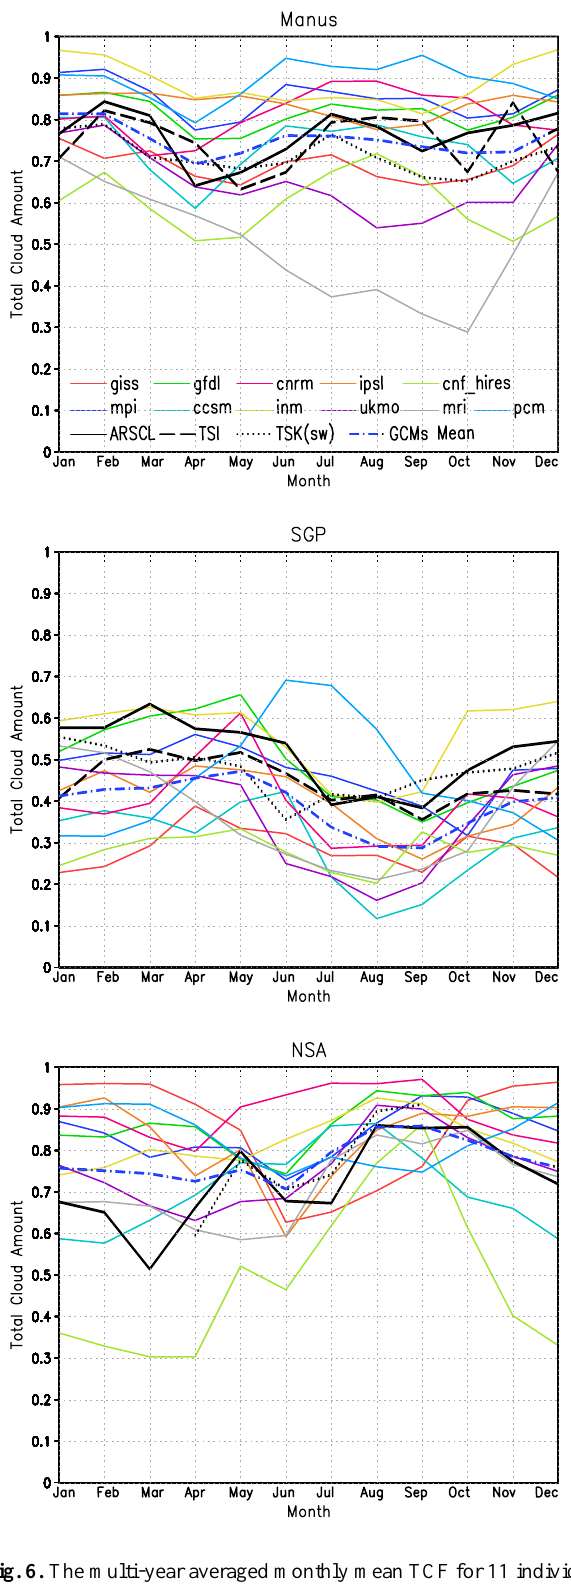
Fig. 6. The multi-year averaged monthly mean TCF for 11 individ- ual GCMs and their average along with three different observations over Manus (top), SGP (middle) and NSA